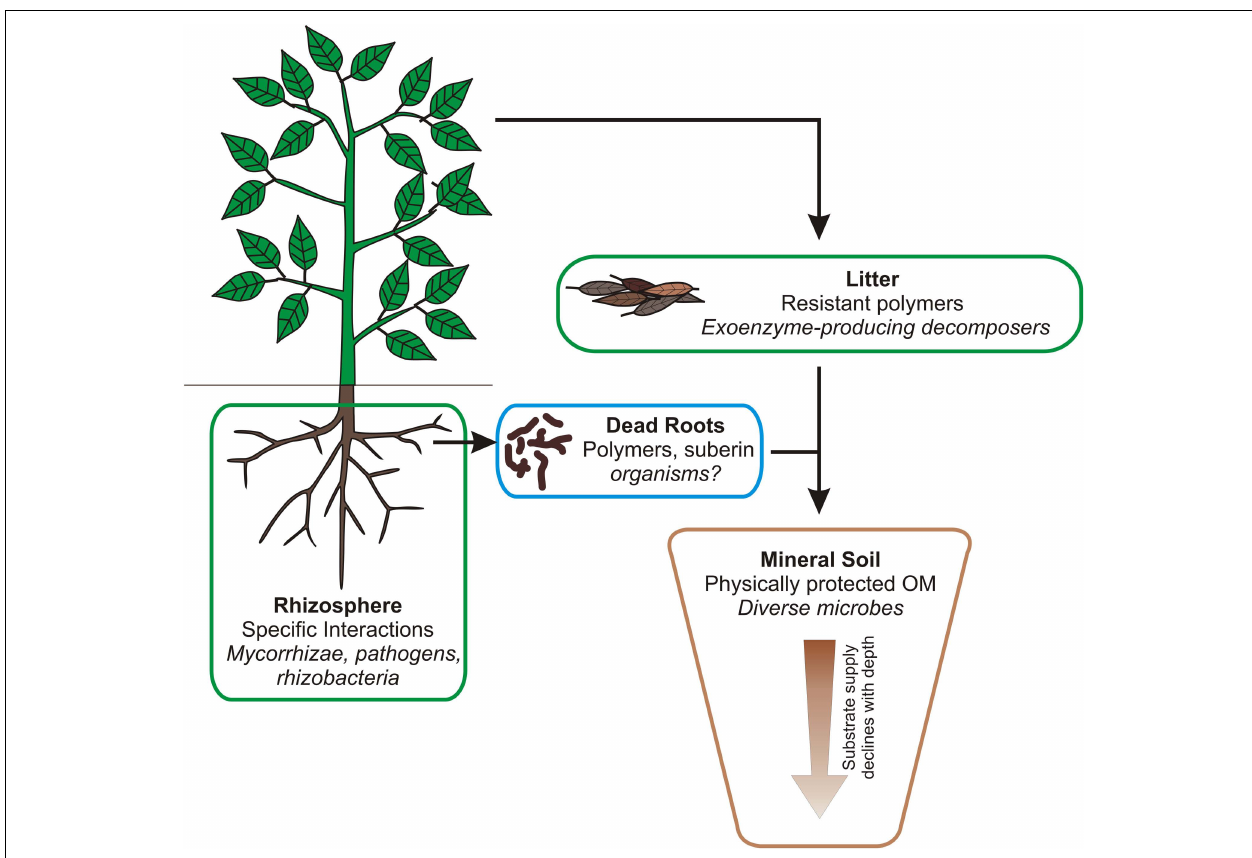
FIGURE 2 |The main zones in soil, the characteristics that regulate microbial functioning within each zone, and the dominant guilds of microbes present. In litter and the rhizosphere (outlined in green), microbial community composition likely affects both the rate of processes and the fate